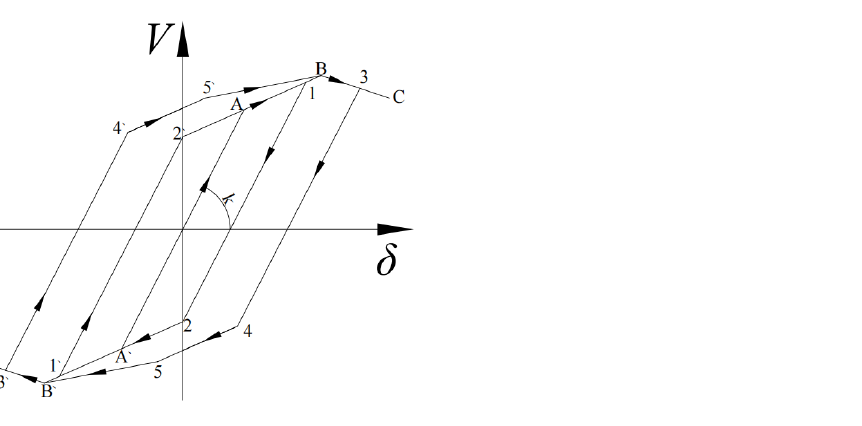
Figure 23. The SRFM for CFTWS lipped channel members failed with strength or global buckling.